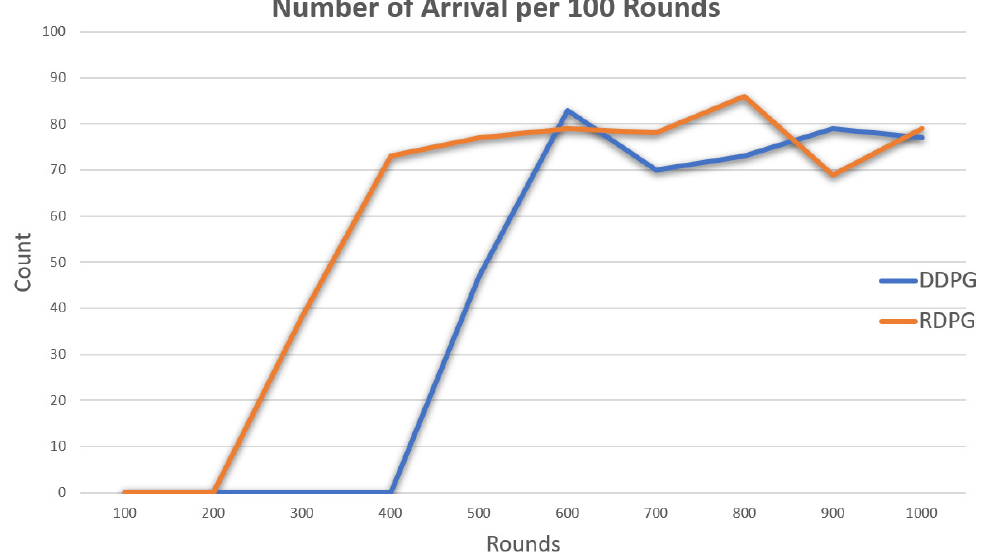
Figure 13. The arrival rate comparison between the DDPG and RDPG in the training procedure.